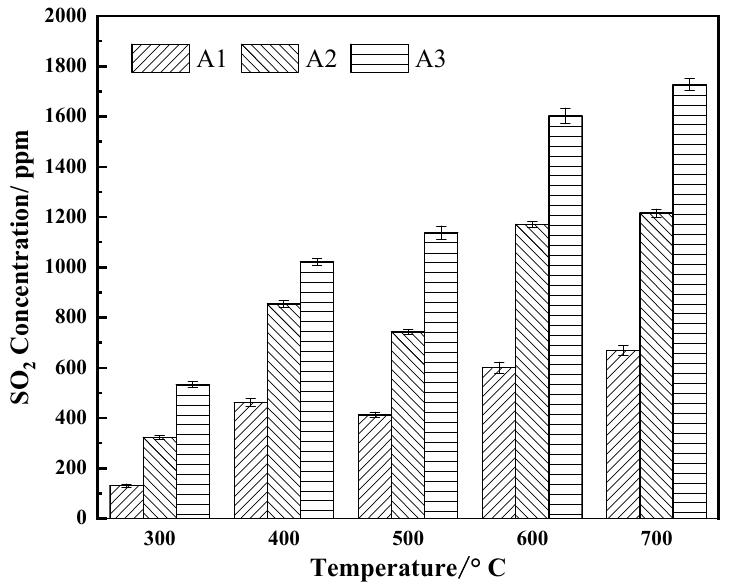
Figure 7. The concentration of SO 2 during thermal desorption of simulated polluted soils under 20% O 2 /N 2 atmosphere at different temperatures. (A1, sample of 1 mL waste oil mixed with 25 g soil; A2, sample of 2 mL waste oil mixed with 25 g soil; A3, sample of 3 mL waste oil mixed with 25 g soil).